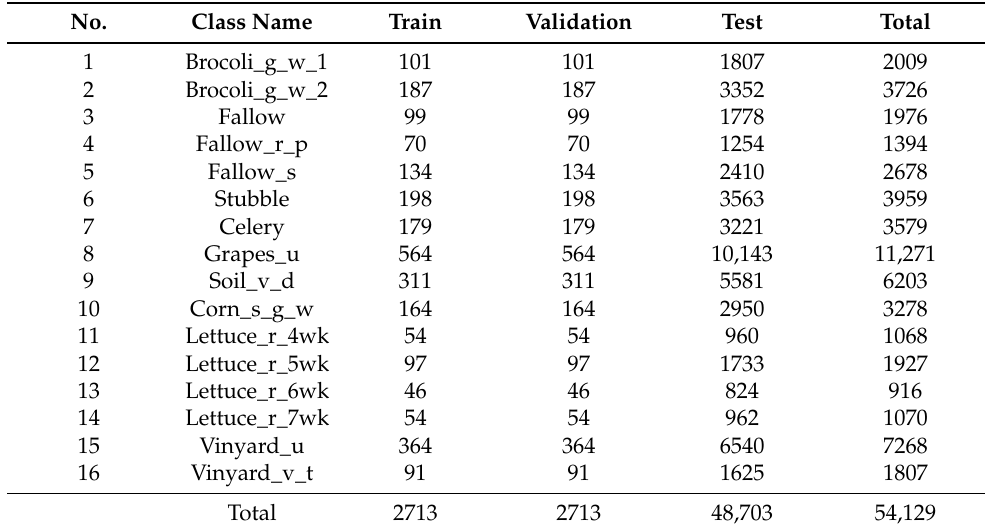
Table 2. Train, validation, and test split of SA dataset.